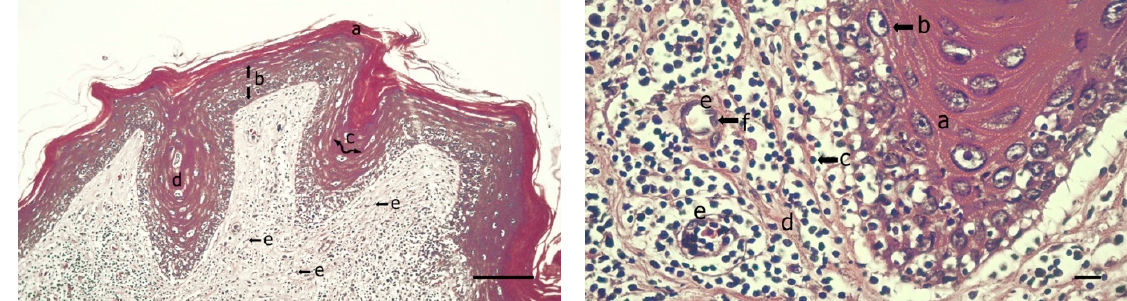
Figure 2. ( Left ) Black turtle ( Chelonia mydas ) cutaneous fibropapilloma. Hematoxylin and eosin. Hyperkeratosis (a), epidermal hyperplasia (b), acanthosis (c), papillary formation supported by a core of fibrovascular stroma (d). Proliferation of fibroblasts in the dermis (e) surrounded by abundant fibrous connective tissue. Scale bar = 100 μ m. ( Right ) Black turtle ( Chelonia mydas ) cutaneous fibropapilloma. Hematoxylin and eosin. Papillary projection (a), ballooning degeneration in cells (b), increased fibroblasts in the dermis (c) surrounded by fibrous connective tissue (d), angiogenesis (e) and mild infiltration of lymphocytes (f). Scale bar = 10 μ m.